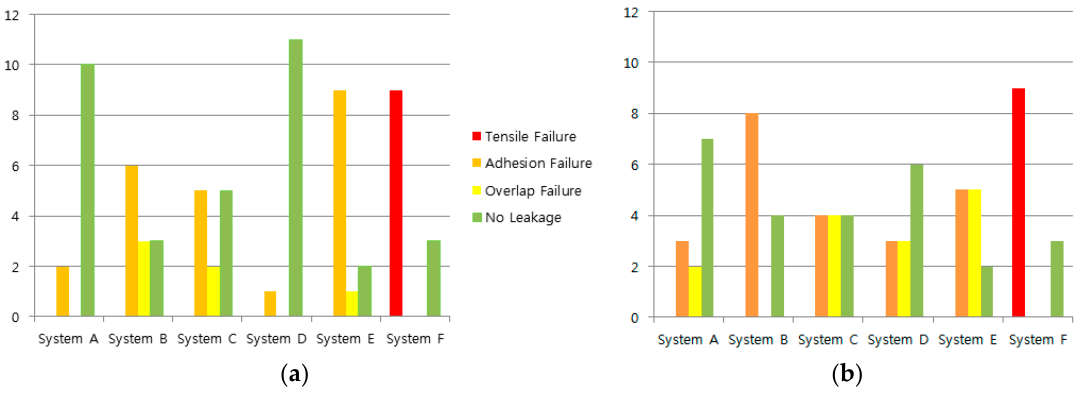
Figure 11. Failure type occurrence rates of waterproofing membrane system types; ( a ) dry surface installed specimen results; ( b ) wet surface installed specimen results.